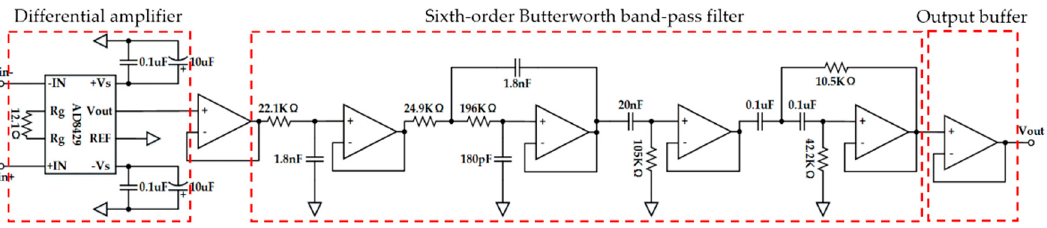
Figure 4. Acquisition module for the angle sensor output signal.